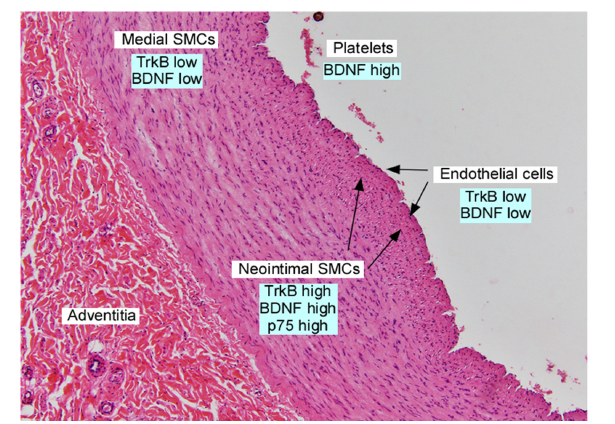
FIGURE 2 | Section of adult human iliac artery, stained with hematoxylin and eosin and annotated with expression of neurotrophins and their receptors in the indicated cell types. Data was derived from Scarisbrick et al. (1993); Donovan et al. (1995), Yamamoto et al. (1996); Kramer (2002), Kraemer et al. (2005), and Chacó-Fernández et al.